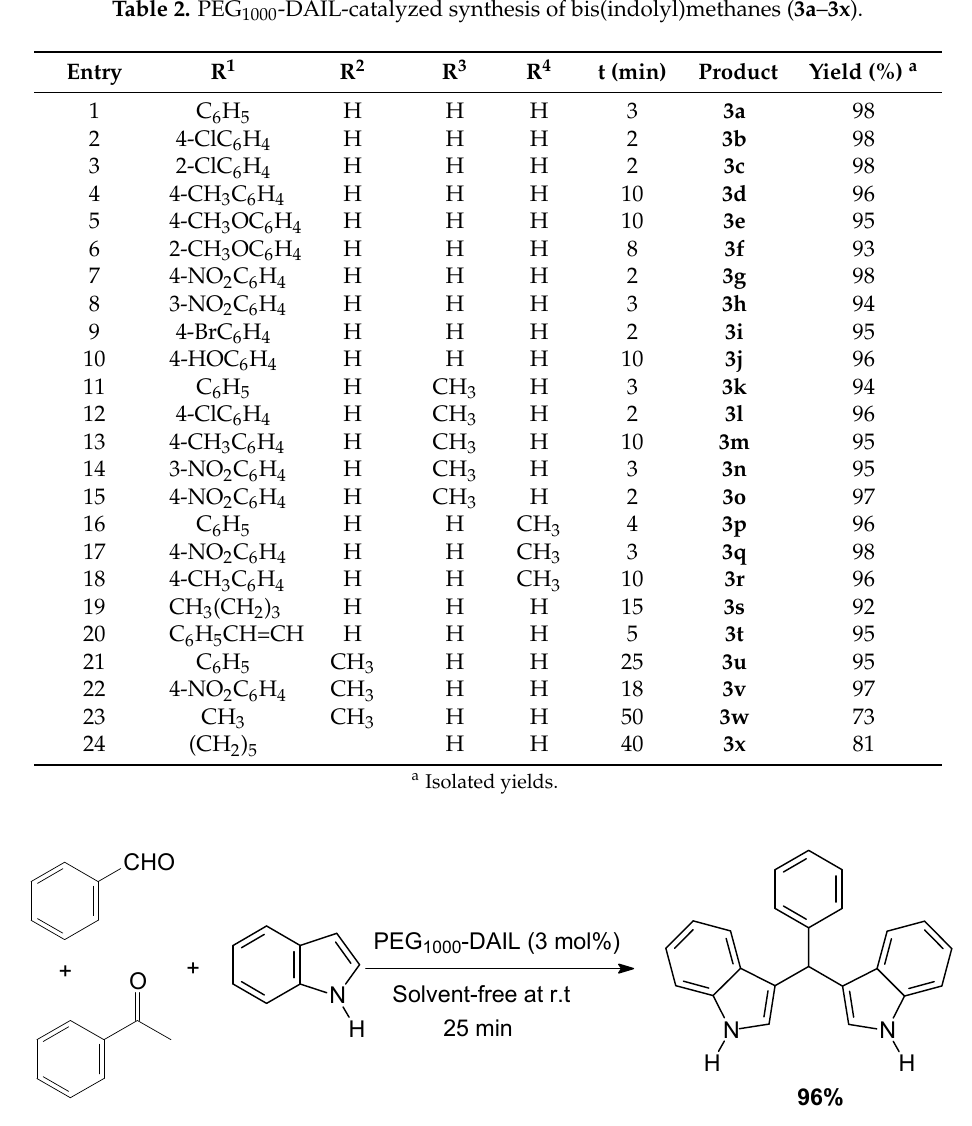
Scheme 2. Chemoselective reactions of carbonyl groups with